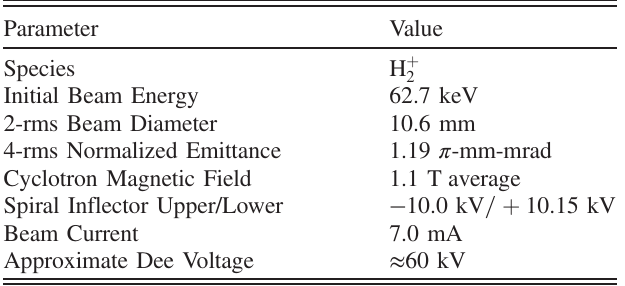
TABLE I. Beam and cyclotron parameters for inflection and acceleration